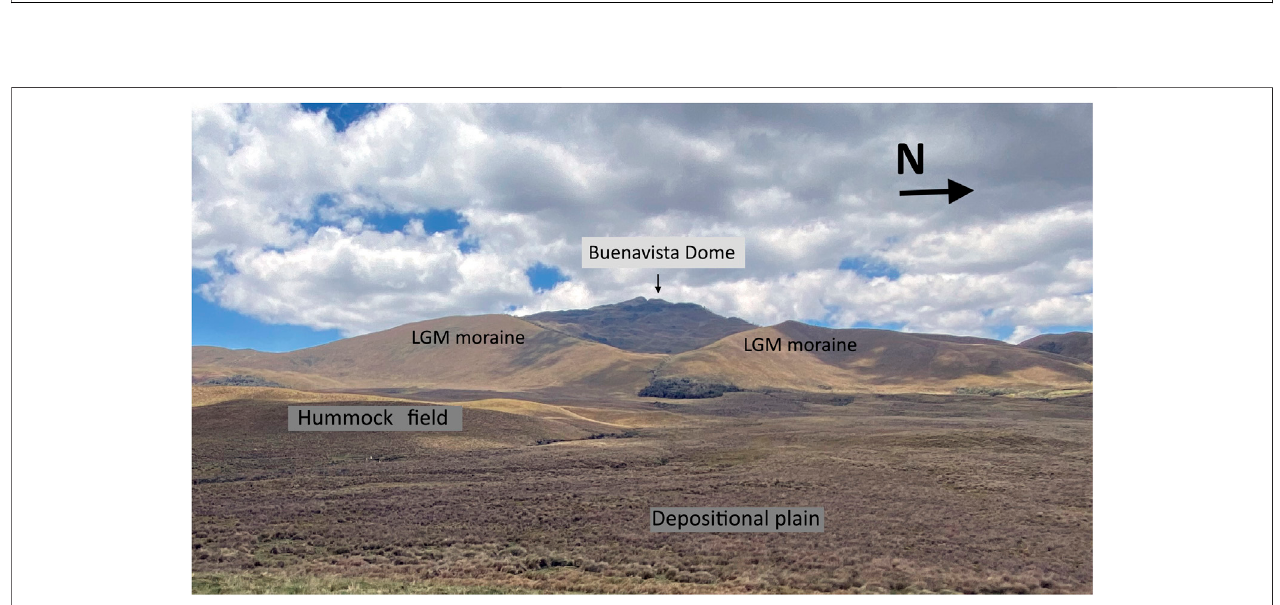
FIGURE 11 | Scar left by destruction of a portion of Buenavista dome ’ s east fl ank whose resulting gravitational fl ow is hypothesized to have formed the hummock fi eld, partially seen in the foreground. View west.